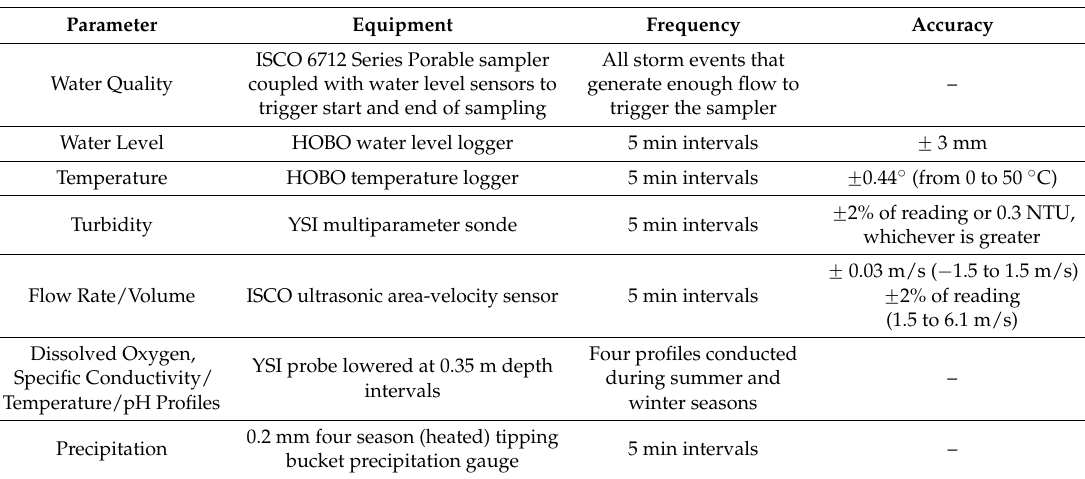
Table 1. USDC monitoring equipment properties and